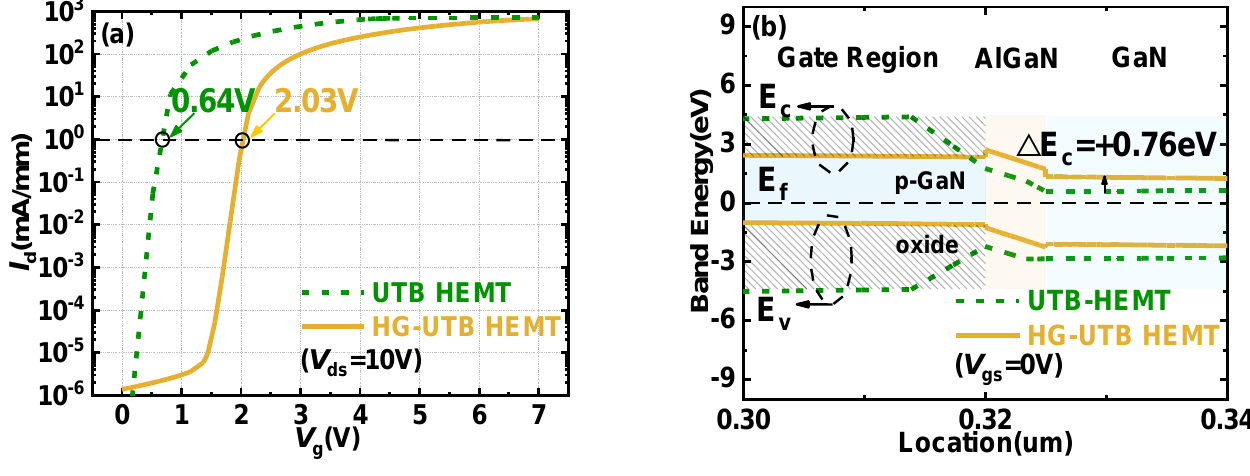
Figure 3. ( a ) Transfer characteristics of UTB HEMTs and HG − UTB HEMTs; ( b ) band energy profile at the left middle area of the gate region. The gate oxide and p − GaN for conventional MIS − gate UTB HEMTs and HG − UTB HEMTs, respectively, are shown.